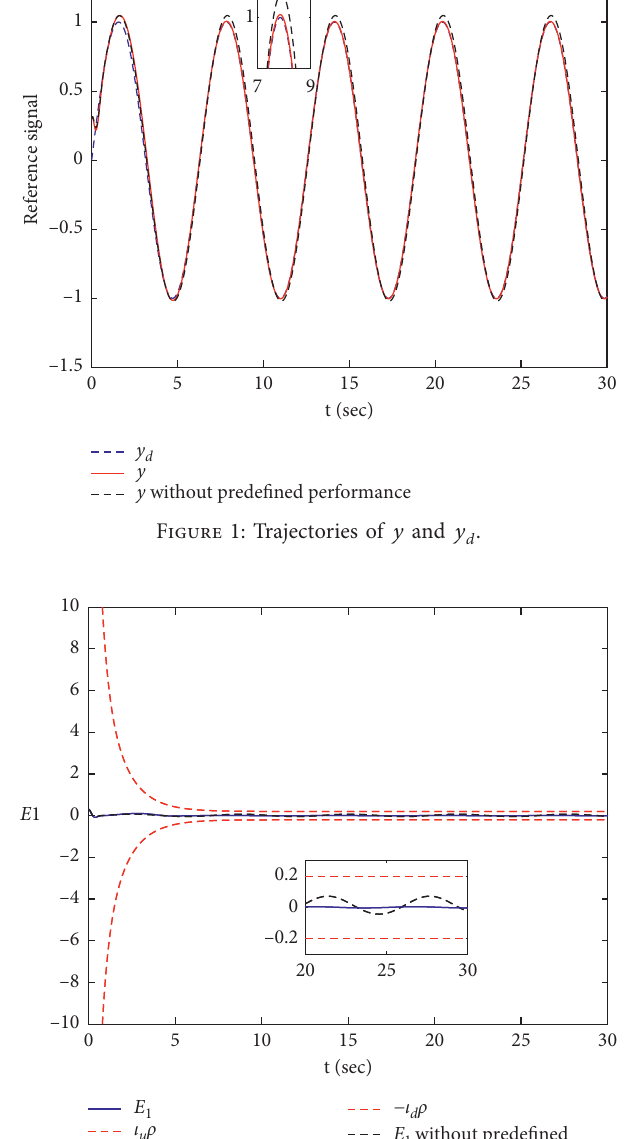
Figure 2: Tracking error E − ι d ρ